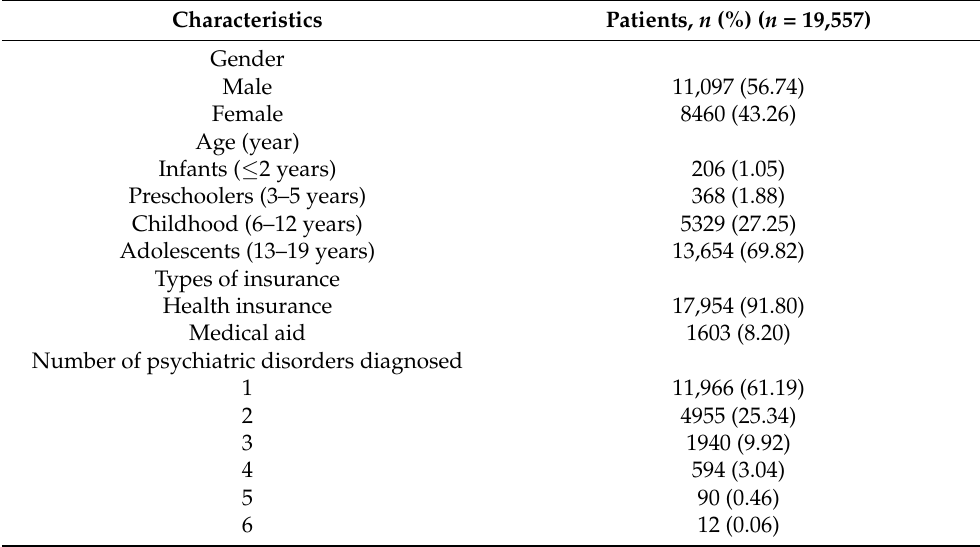
Table 2. General characteristics of pediatric and adolescent patients with psychiatric